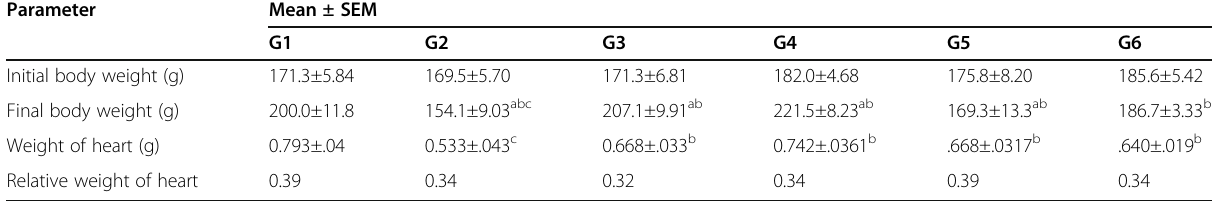
Table 2 Effect of extract M. verticillata on the (Mean ± SEM) body weight (g) for 6 weeks in albino rats ( n =6) Parameter Initial body weight